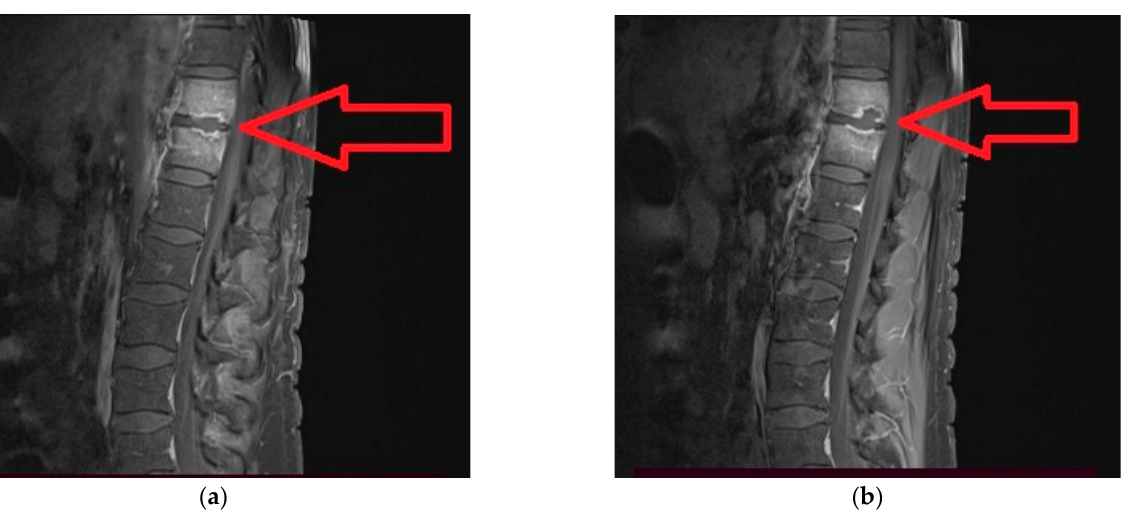
Figure 1. MRI sagittal section segment dorso-lumbar spine T2 TSE: Vertebral intraspongiosis bone edema T11 and T12 (hypersignal T2), disruption of the bone cortex adjacent to the T11 disc with disc damage.